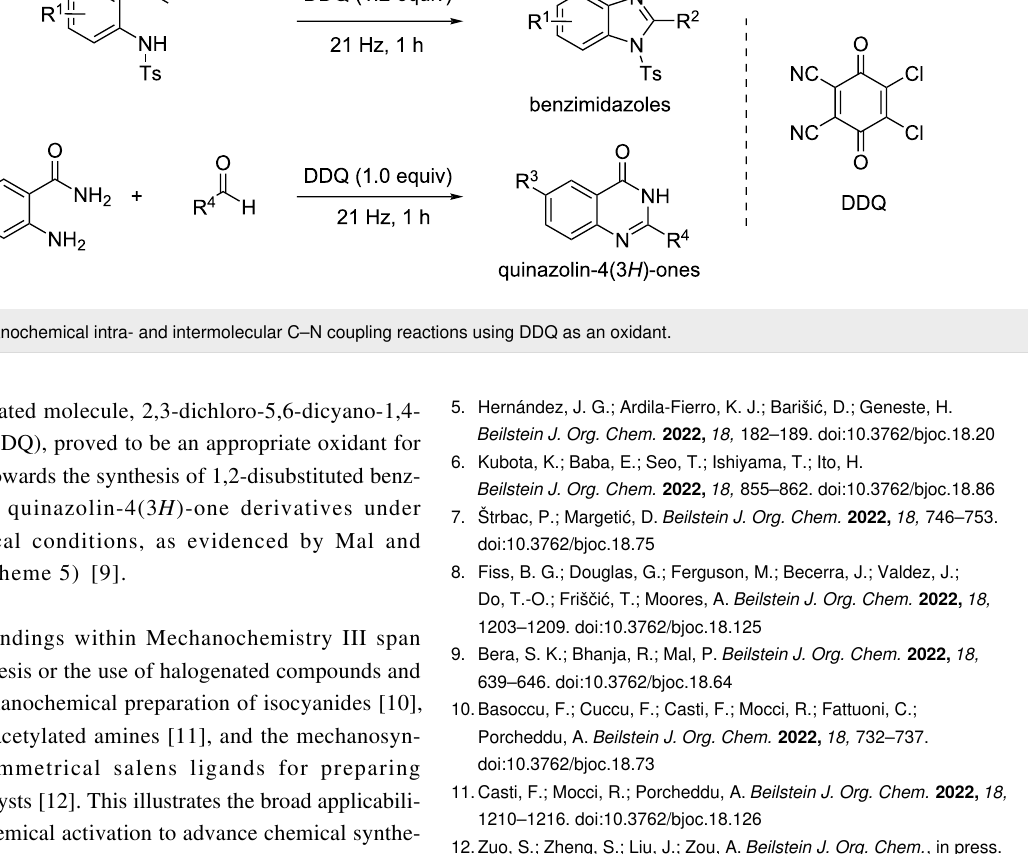
Scheme 5: Mechanochemical intra- and intermolecular C–N coupling reactions using DDQ as an oxidant.